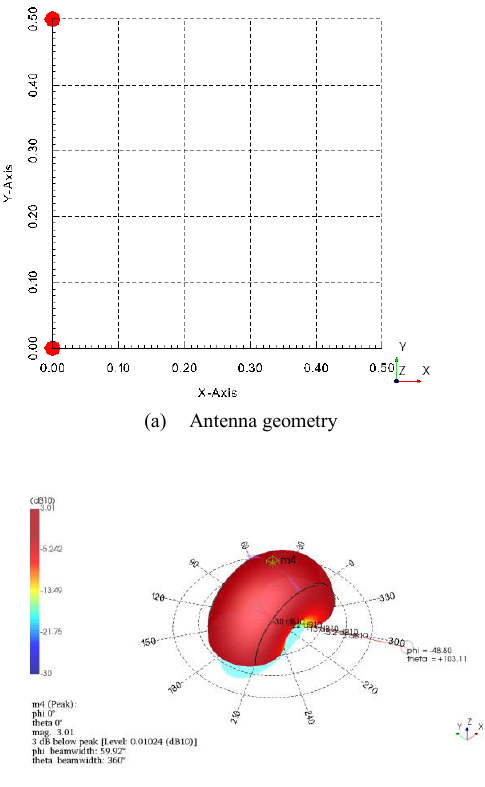
Figure 8. Linear antenna array (N=2, dy = 0.5λ , βy = 0°)